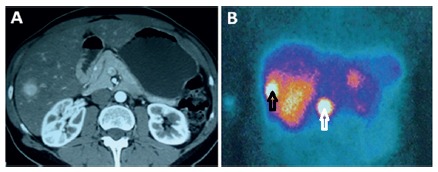
A) Arterial phase of a CT exam showing a homogeneous arterialized lesion in segment VI of the liver; B) OctreoScan examination revealed abnormal capture of the contrast in the pancreas (white arrow) and in the lesion previously identified on CT (black arrow). The diagnosis was pancreatic neuroendocrine tumor with liver metastasis.